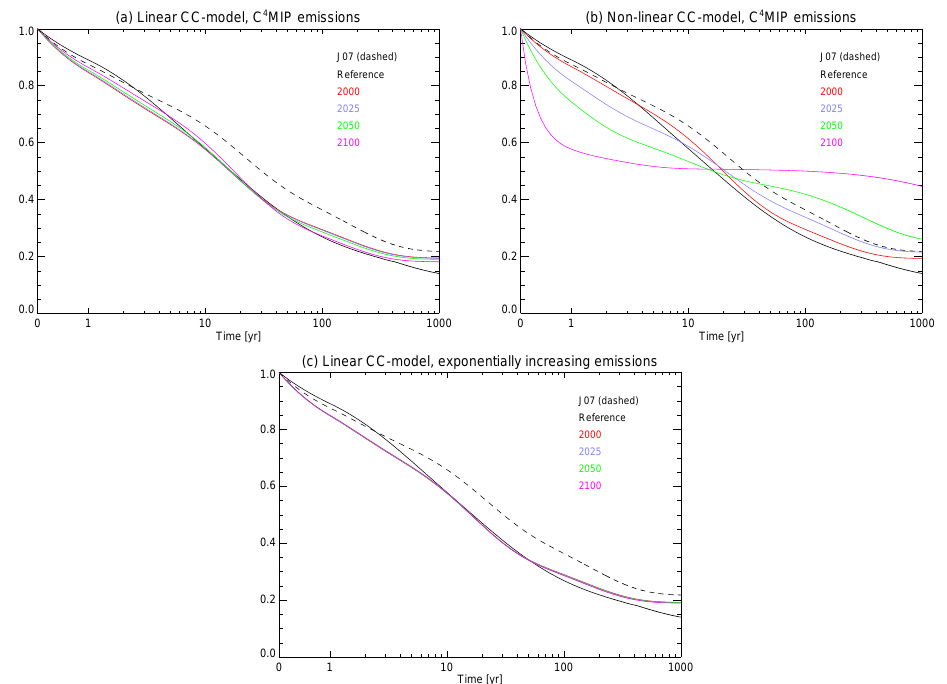
Fig. A1. IRF CO 2 derived for the CC-model of Joos et al. (1996), when using data up to year 2000 (red), 2025 (blue), 2050 (green), and 2100 (purple). The solid black line indicates the proper IRF CO 2 from this CC-model, and the dashed black line shows the J07 IRF CO 2 . (a) IRF CO 2 derived from data generated with the linearized version of the CC-model forced by C 4 MIP emissions. (b) IRF CO 2 derived from data generated with the non-linear CC-model forced by C 4 MIP emissions. (c) IRF CO 2 derived from data generated with the linearized version of the CC-model forced by exact exponentially increasing emissions.